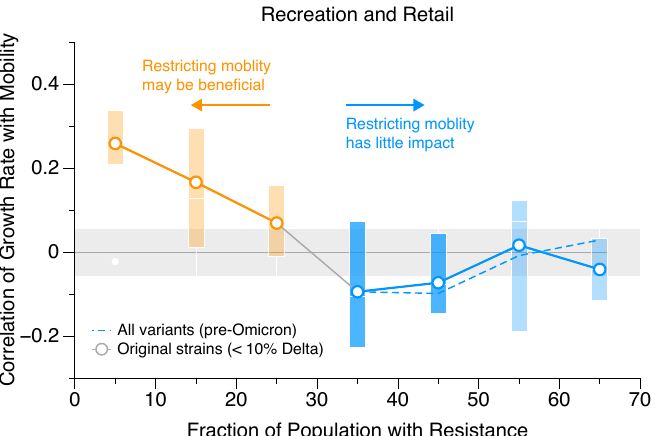
Figure 7. Correlation between COVID-19 transmission rates and mobility in recreation and retail establishments as a function of the fraction of the population with resistance. The solid line only includes pre-Delta variants; the dashed line represents all variants, including Delta. Points in which there is a clear correlation are orange; points where the correlation is indistinguishable from zero (suggesting that mobility-restricting measures are no longer effective) are blue.